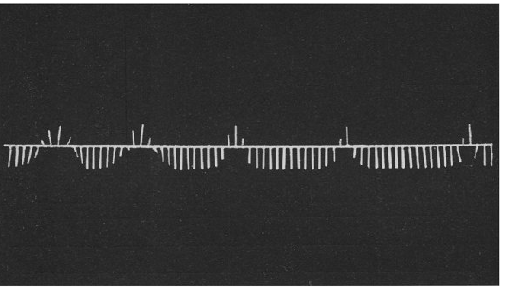
Figure 12. Visualization of the Lorentzian contraction of the width of the Frenkel–Kontorova kink (see the text for